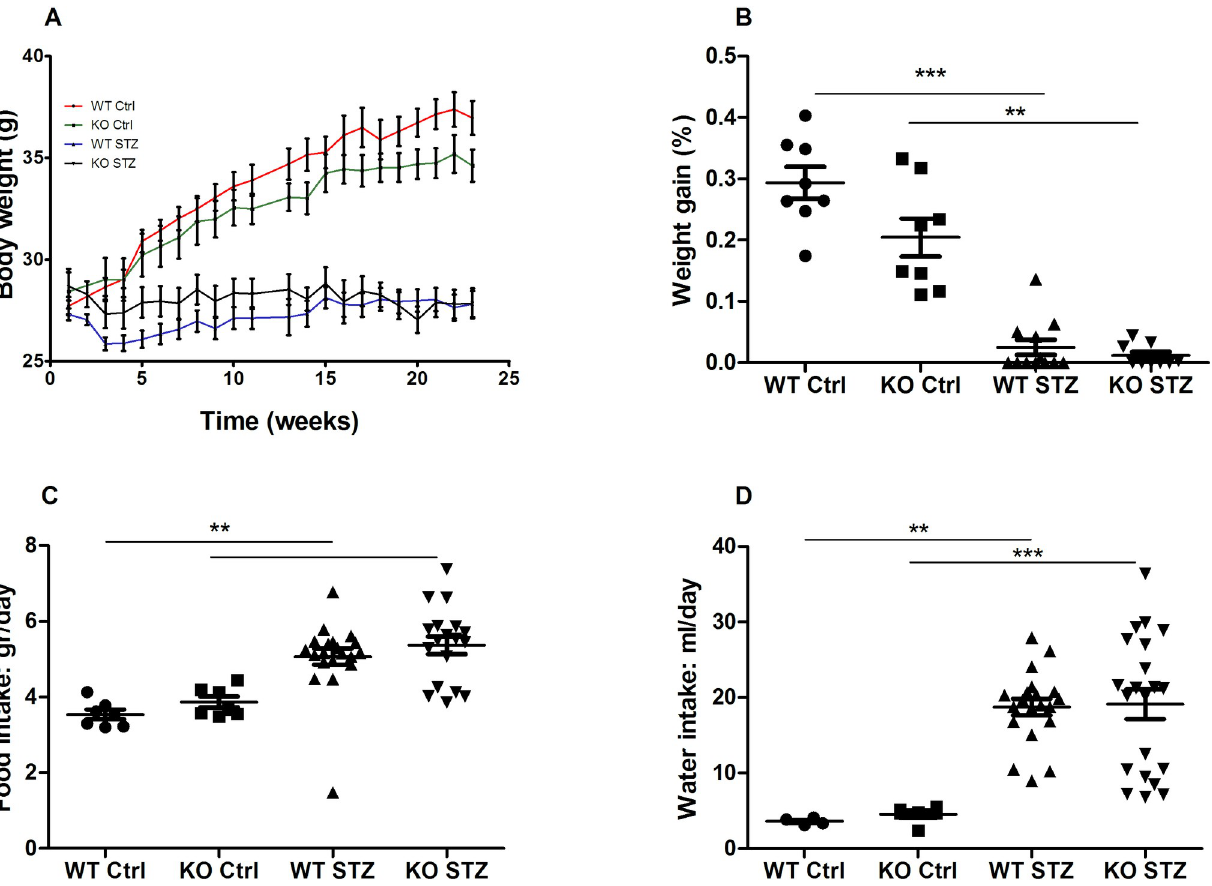
Fig 1. Metabolic parameters: Body weight, weight gain, food intake, and water intake. (A) Body weight measured weekly for 24 weeks. (B) Weight gain calculated as a percentage of original body weight. (C-D) Food and water intake measured in the final 3 weeks of the study. Data shown as mean ± SEM. �� p < 0.01, ��� p <